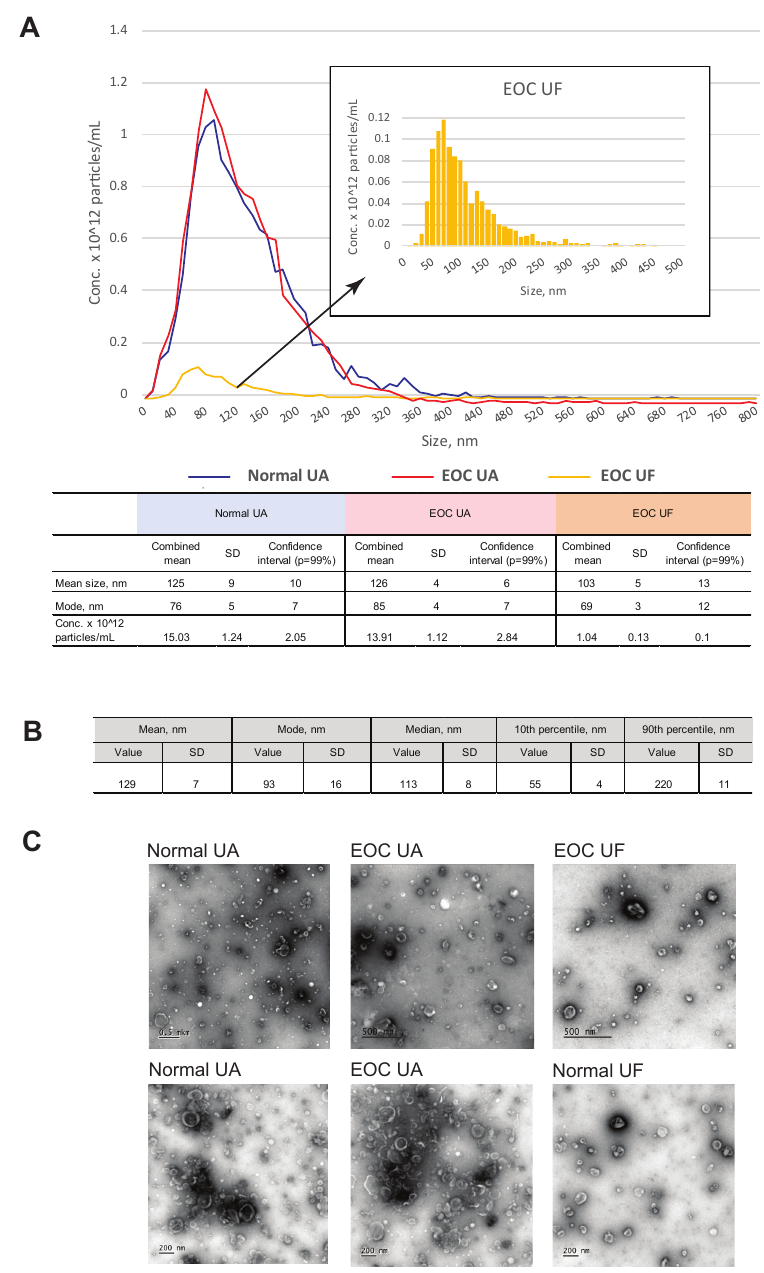
Figure 1. Analysis of the EV size and morphology. ( A ) NTA data for evaluation of the EV size distribution and concentration. Examples of the analysis of EVs isolated from a uterine aspirate of an ovarian cancer patient (EOC UA), a uterine aspirate of a healthy donor (Normal UA) and a uterine flush of an ovarian cancer patient (EOC UF). ( B ) Mean values for the EV size, median and mode over the entire sampling. ( C ) TEM analysis of the EV morphology. Examples of EVs isolated from: uterine aspirates from two healthy donors (Normal UA), uterine aspirate from two EOC patients (EOC UA), uterine flush from an EOC patient (EOC UF) and uterine flush from a healthy donor (Normal UF). The scale bars correspond to 500 nm (upper row) and 200 nm (bottom